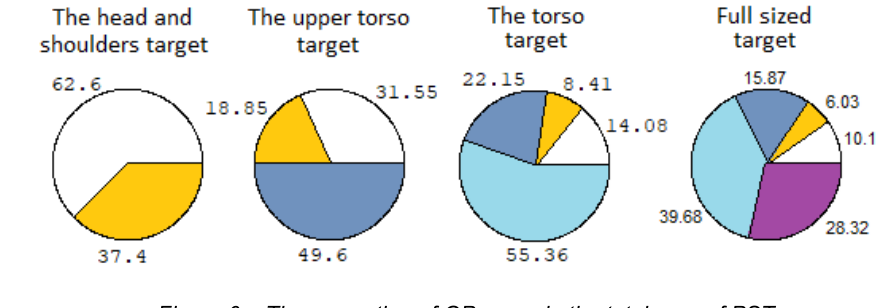
Figure 6 – The proportion of GP areas in the total area of PSTs Рис . 6 – Доля площади геометрических примитивов в общей площади стрелковых